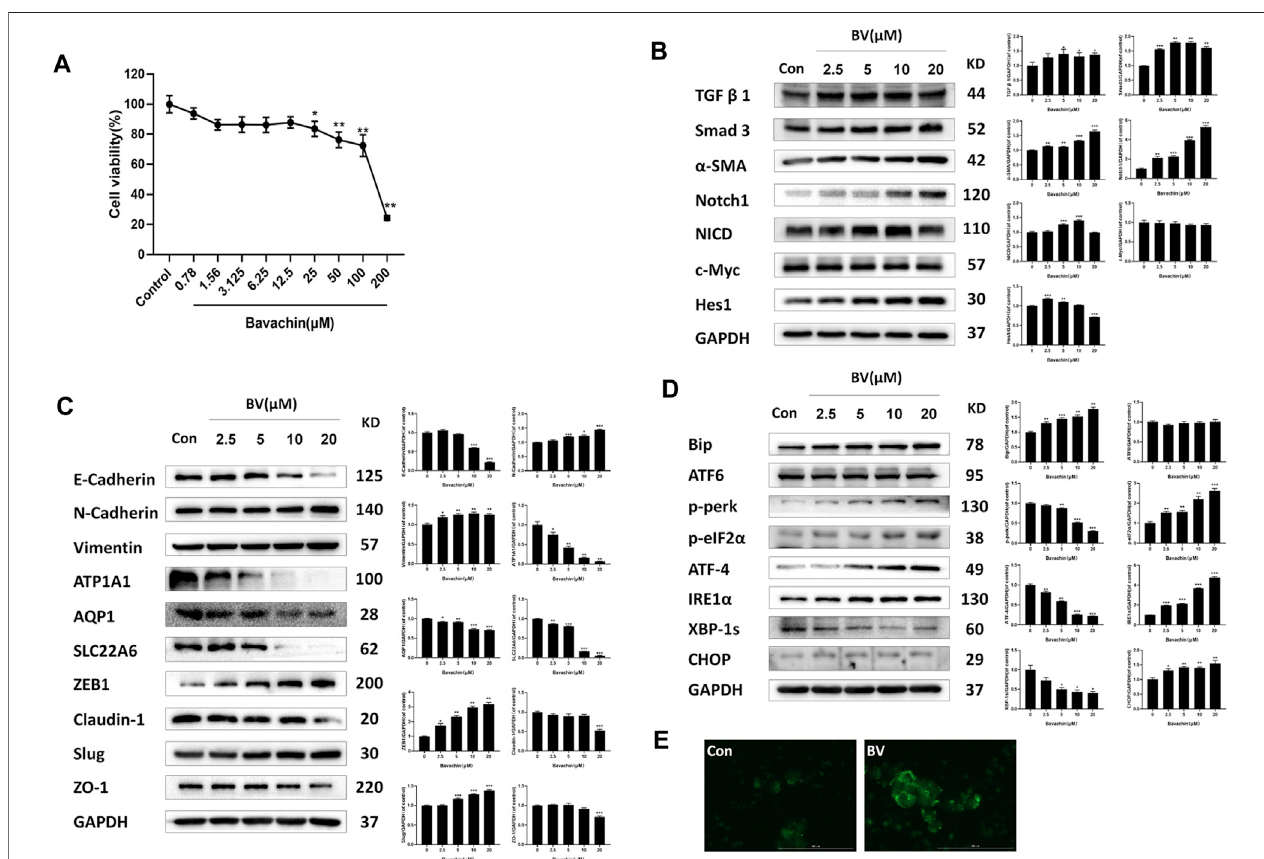
FIGURE2| BVcausedperturbationsinERstress-, fi brosis-andEMT-relevant signalingpathways invitro . (A) CellviabilityofHK2cellsafter 24 hBVtreatment was detectedbyCCK-8assay.Theexpressionsofindicatedproteinsinvolvedin fi brosis (B) andEMT (C) inHK2cellsweremeasuredusingwesternblot. (D) Theexpressions of ER stress and UPR-associated proteins in BV-treated cells. (E) The intracellular concentration of Ca 2+ was demonstrated using Fluo 4-AM (scale bar: 100 μ m). * p < 0.05, ** p < 0.01, and *** p < 0.001 vs. the control groups.